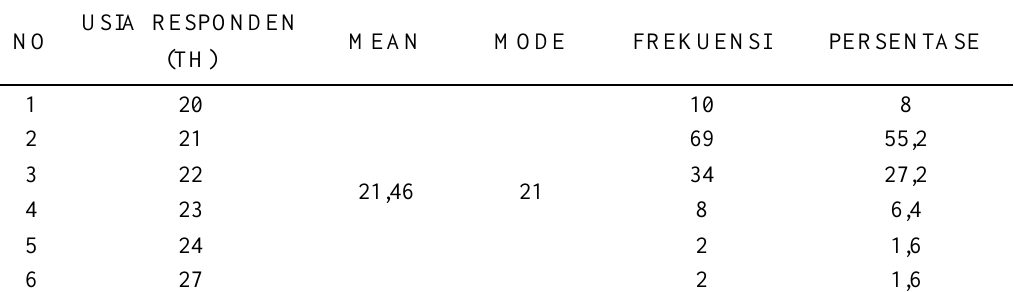
Tabel IV.1 Responden Berdasar Usia